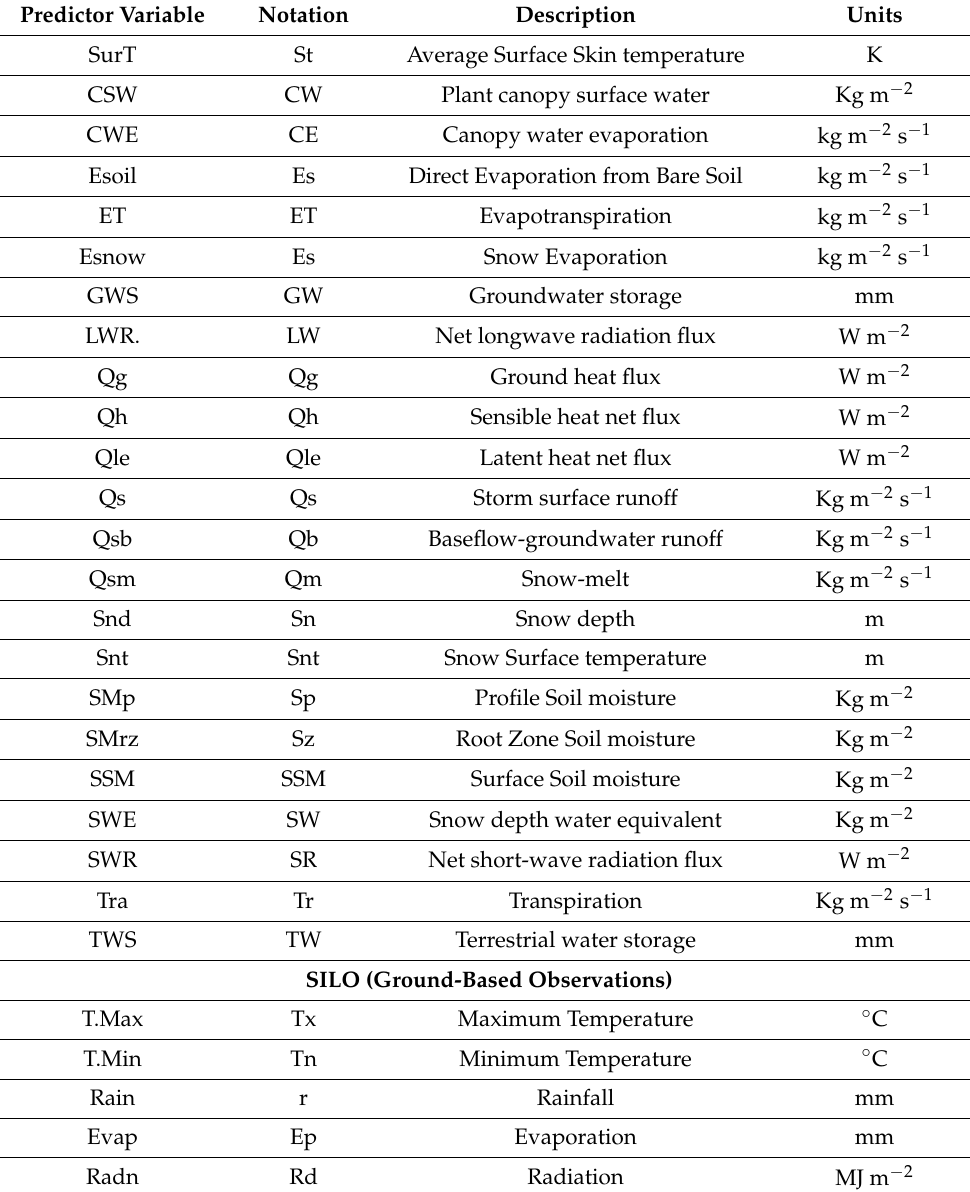
Table 2. Description of the global pool of 52 predictor variables used to design and evaluate hybrid CEEMDAN-CNN-GRU predictive model for daily surface soil moisture forecasting. GLDAS 2.0: Modis Satellite Data from Giovanni